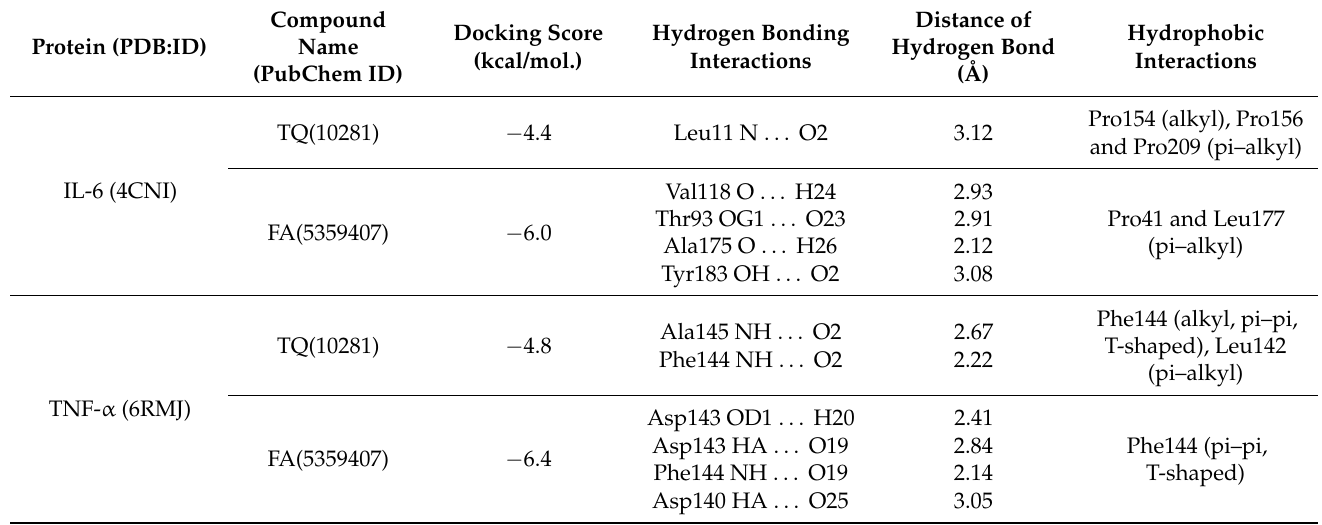
Table 1. Docking score, hydrogen, and hydrophobic interaction of ligands with target receptors.